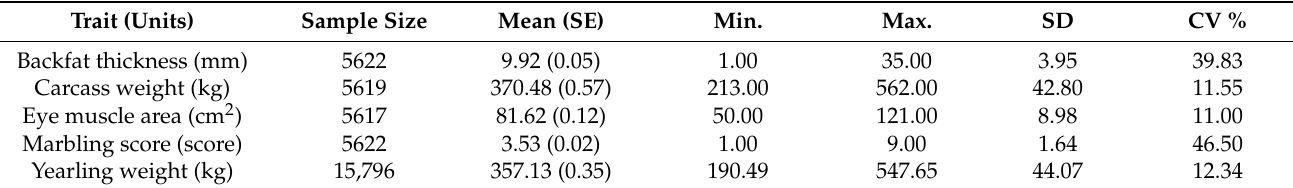
Table 1. Summary statistics for phenotypic data used to estimate variance components in Hanwoo cattle. Trait